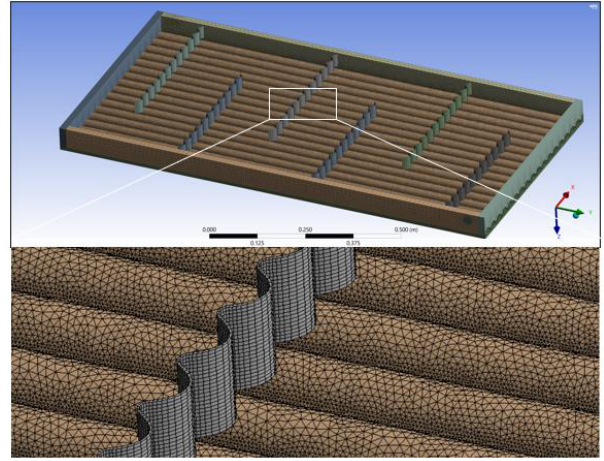
Figure 2. Surface mesh for the solar air heater.